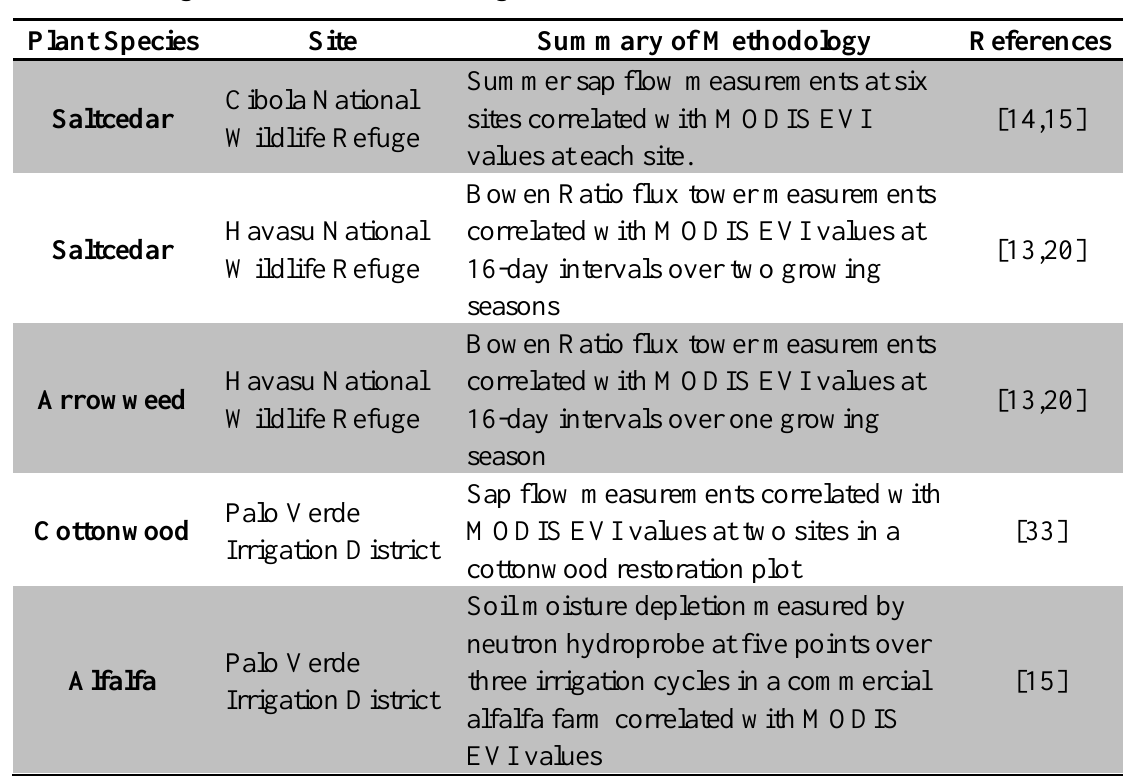
Table 1. Sites and methods used to correlate ground estimates of ET with MODIS Enhanced Vegetation Index values along the Lower Colorado